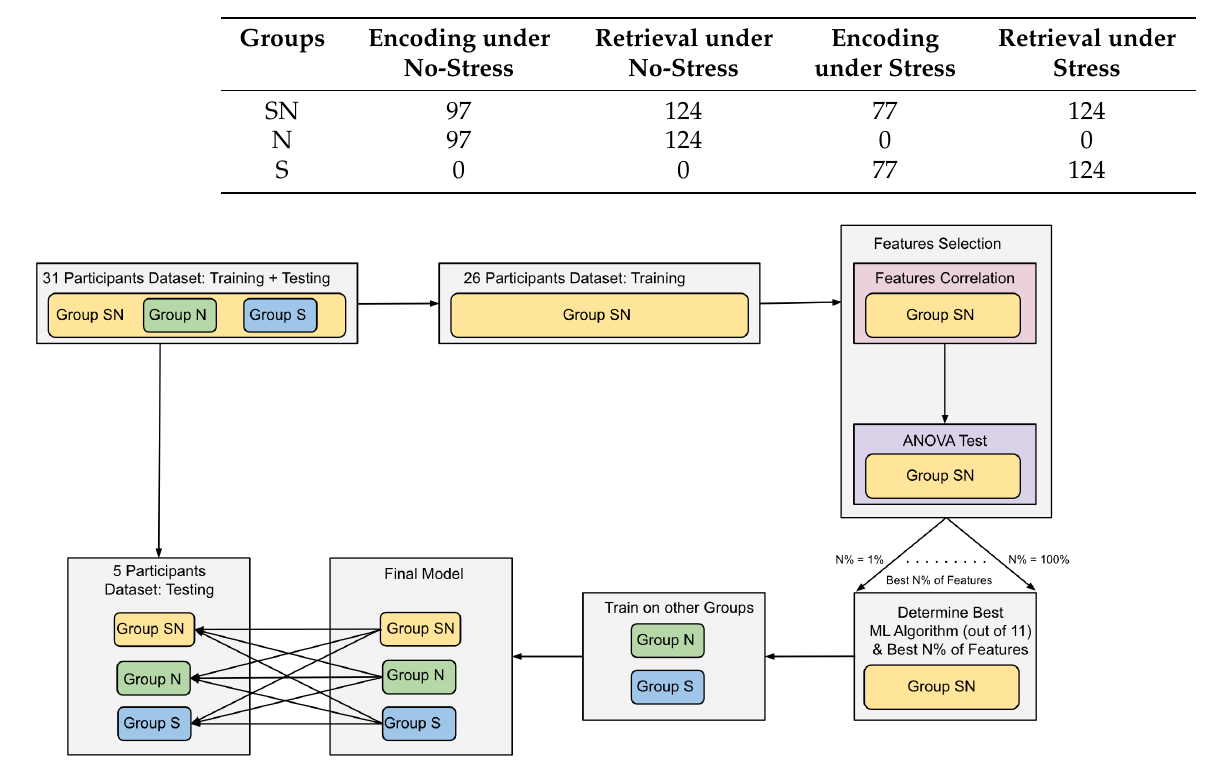
Table 2. Encoding and Retrieval Data Groups for ML classification. SN refers to data collected during both stress and no-stress conditions. Similarly, N refers to no-stress condition data, and S refers to stress condition data.